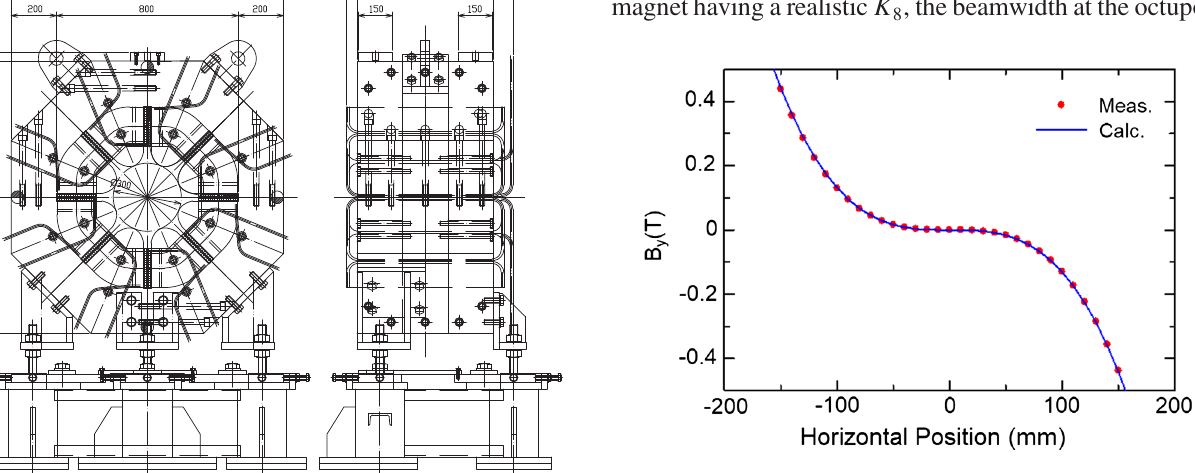
FIG. 11. Schematic drawing of fabricated octupole magnet.